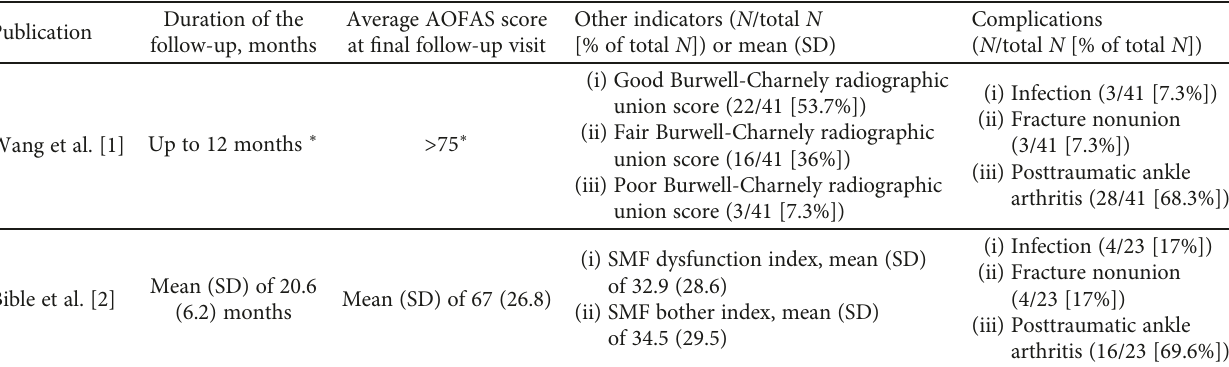
Table 3: Posttreatment